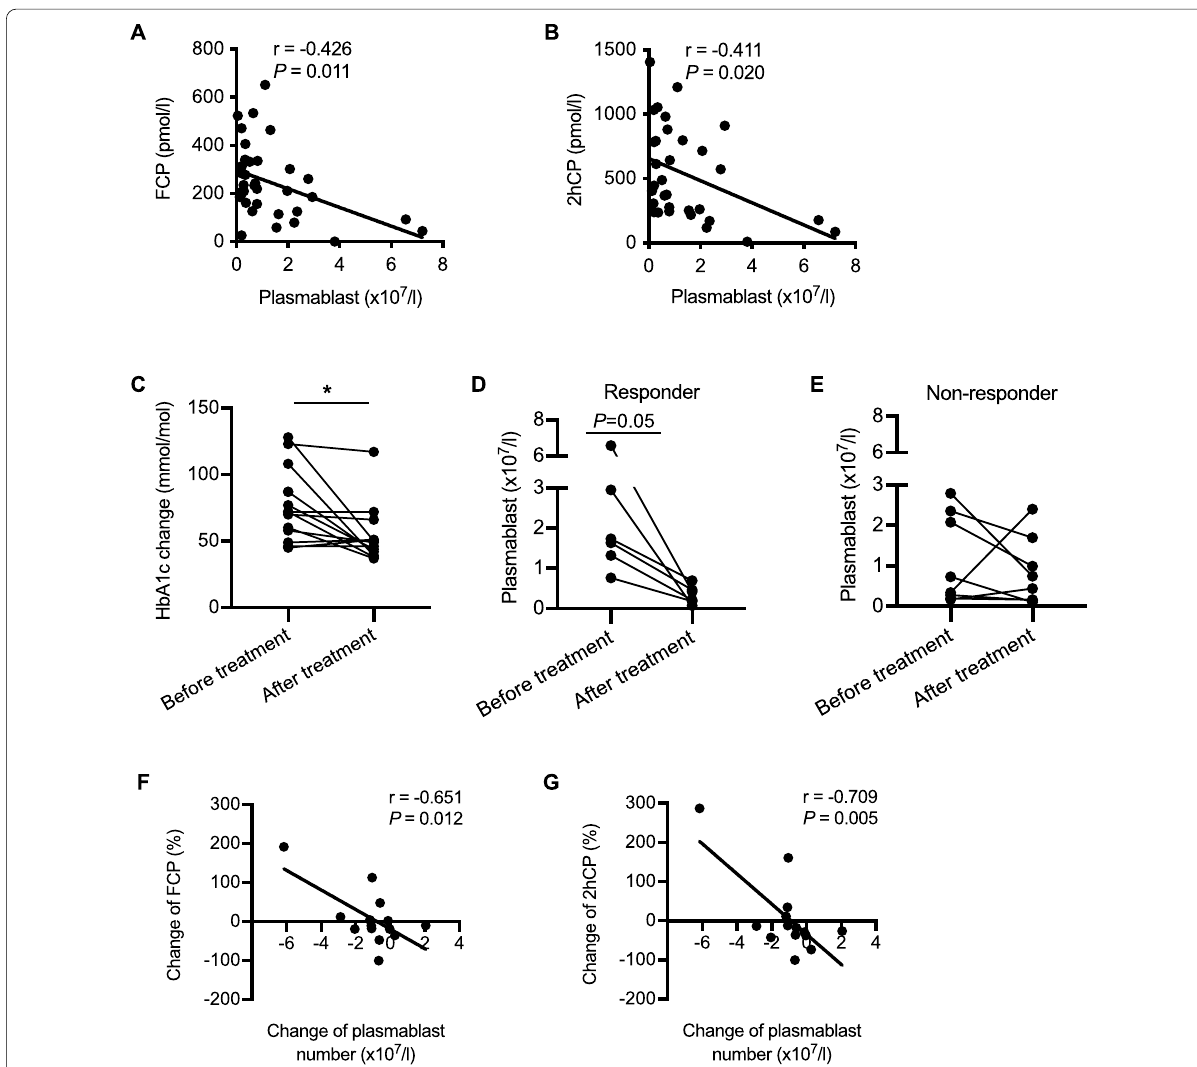
Fig. 2 The increase of plasmablasts correlates with the deterioration of beta cell function. A – B Correlation between the number of plasmablasts and FCP (n 35) and 2hCP (n 32) in patients with new-onset T1D. C HbA1c levels in patients receiving MSC transplantation at baseline and = = 3 months after transplantation. D – E Plasmablast number at baseline and 3 months after treatment in responders ( D ) and non-responders ( E ). F – G Correlation between the altered plasmablast number and the change of FCP and 2hCP. Correlation was assessed by Pearson analysis. Difference between the data before and after MSC treatment were assessed by Paired t test. * P < 0.05. FCP, plasma fasting C-peptide; 2hCP, plasma